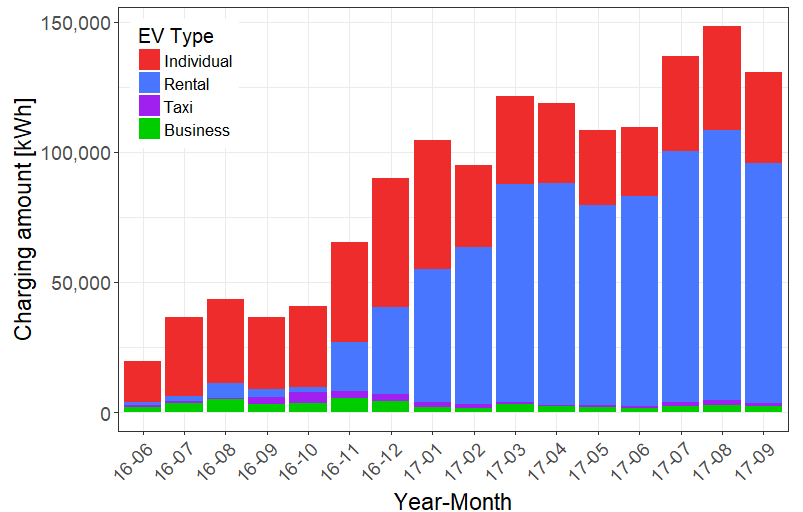
Figure 2. EV charging state by type in Jeju.